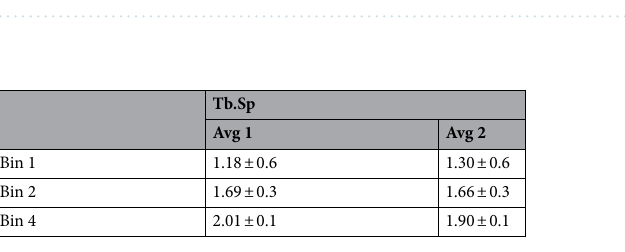
Table 5. Mean and standard deviation of Tb.N values, according to frame averaging (Avg 1 or Avg 2) and data binning (Bin 1, Bin2, and Bin 4).